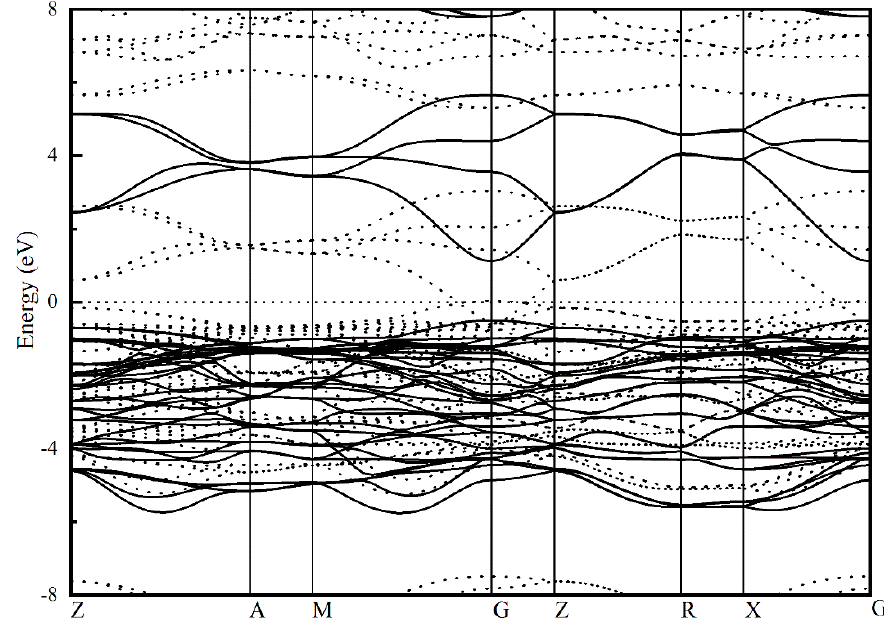
Figure 2. Calculated electronic band structure of MgBi 2 O 6 using hybrid functional PBE0 method. Band structure from conventional DFT calculation (dotted line) is also presented for comparison.